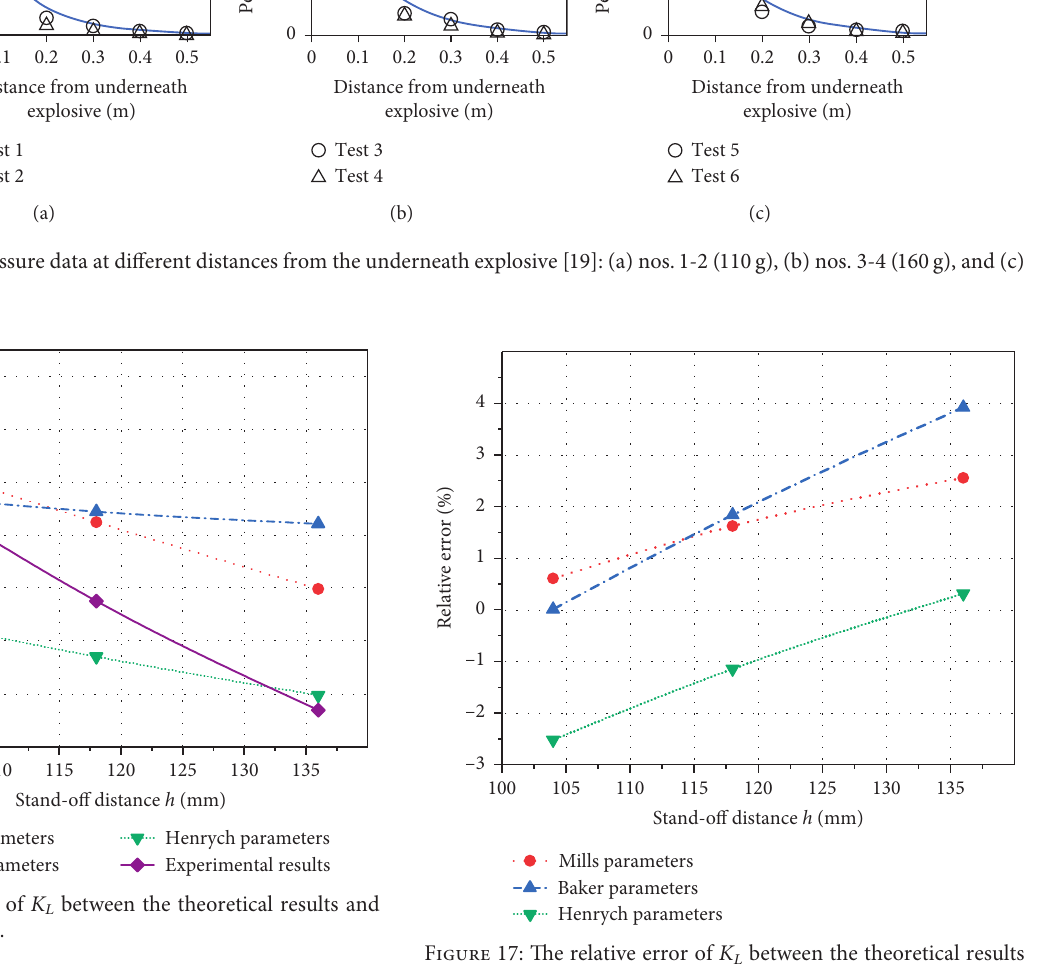
L between the theoretical results